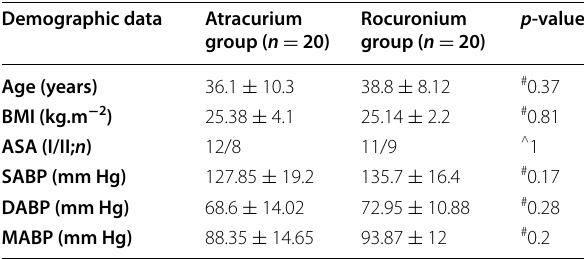
Table 1 Comparison between groups concerning demographic